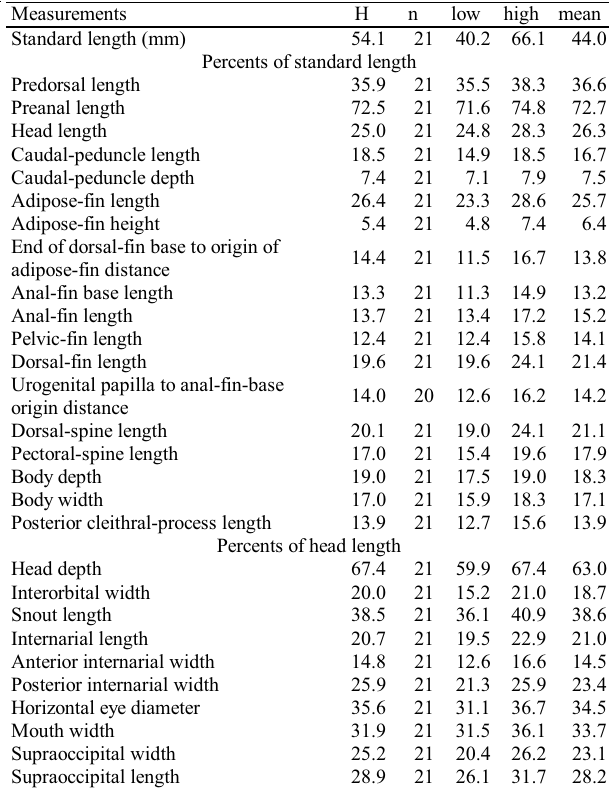
Table 1. Morphometric data of Pimelodus stewarti . Range includes the holotype